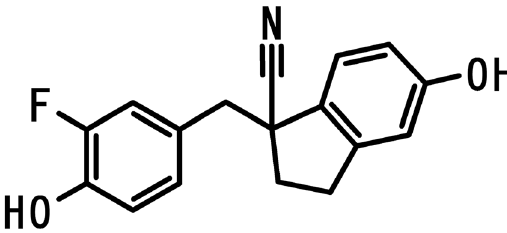
Figure 1. Chemical structure of C-1.